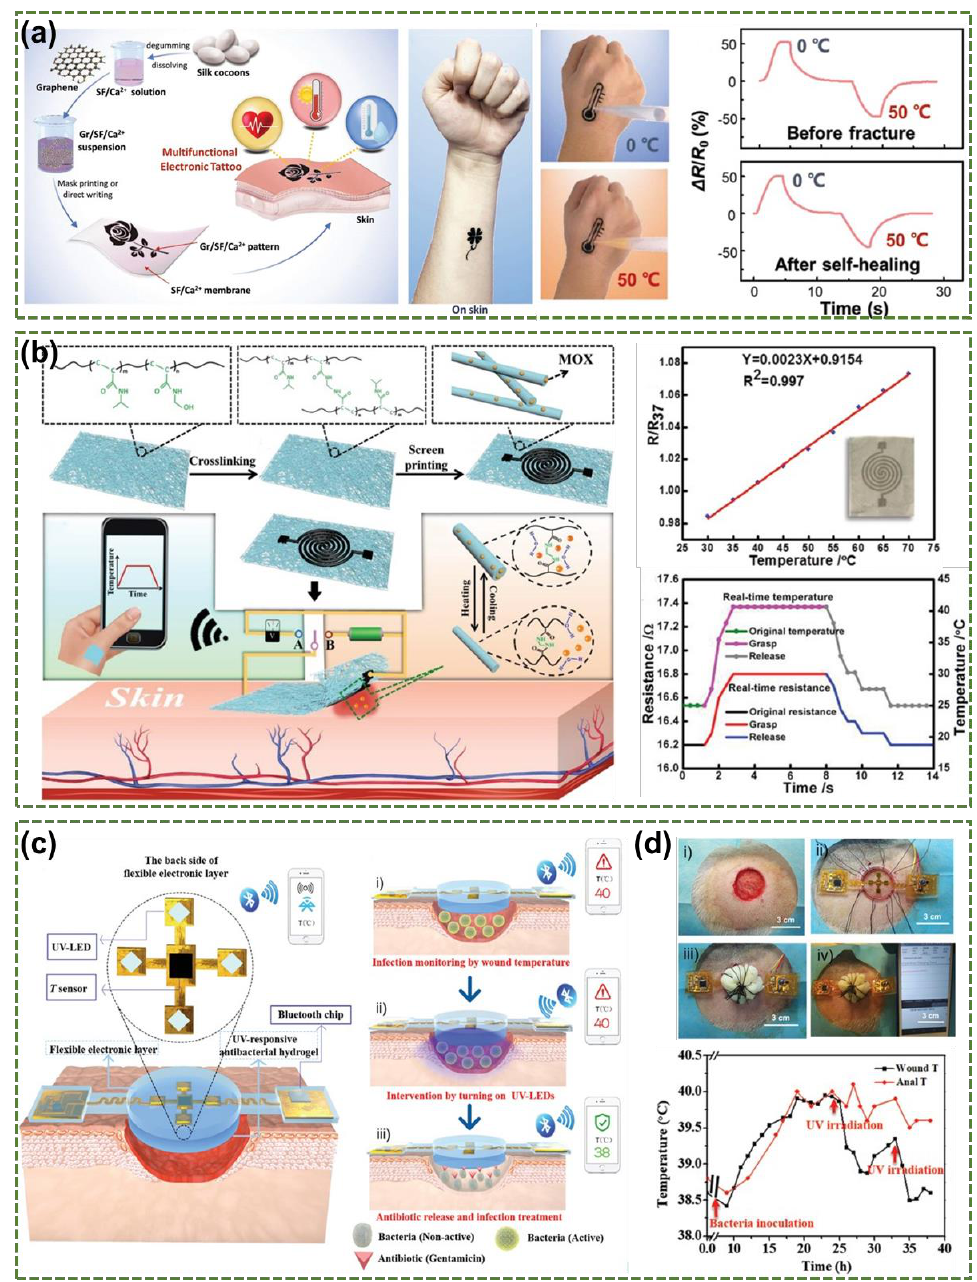
Figure 6. ( a ) Schematic illustration of the fabrication process of Gr/SF/Ca 2+ E-tattoo and relative resistance changes of pristine and healed temperature sensors (Reprinted with permission from [89]). ( b ) The fabrication and temperature sensing performance of flexible and breathable on-skin devices featuring temperature triggered drug release ability (Reprinted with permission from [99]). ( c ) Schematic illustration of the structures and working principles of the smart wound dressing integrated with flexible electronics and UV-triggered drug release: (i) real-time monitoring of wound temperature; (ii) turning on UV light to trigger the drug release; (iii) infection inhibition, resulting in a decreased wound temperature; ( d ) In vivo studies of the smart wound dressing on infection monitoring and timely treatment: (i) wound creation; (ii) implantation of smart system; (iii) pressure dressing; (iv) real-time temperature monitoring. (Reprinted from [101] ). Besides the resistive temperature sensors, the wearable temperature sensors based on other mechanisms (e.g., capacitance, impendence, thermomagnetic) are also being widely studied. Recently, Lu et al., developed an LC (inductance-capacitance) oscillator